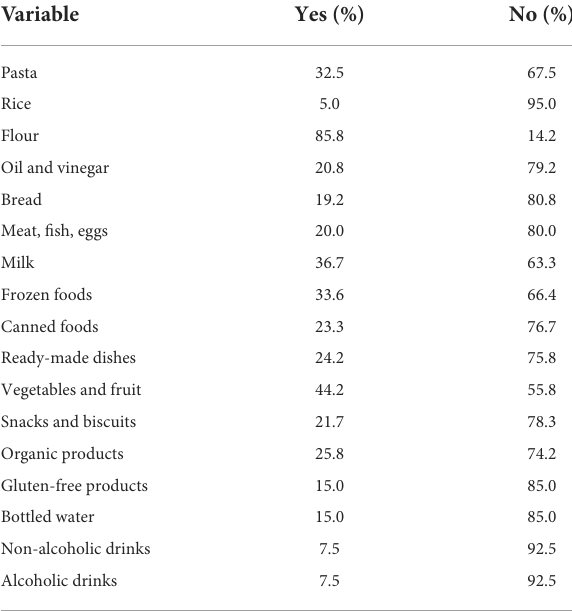
TABLE 9 Summary statistics of percentages regarding shortages of specific food products.